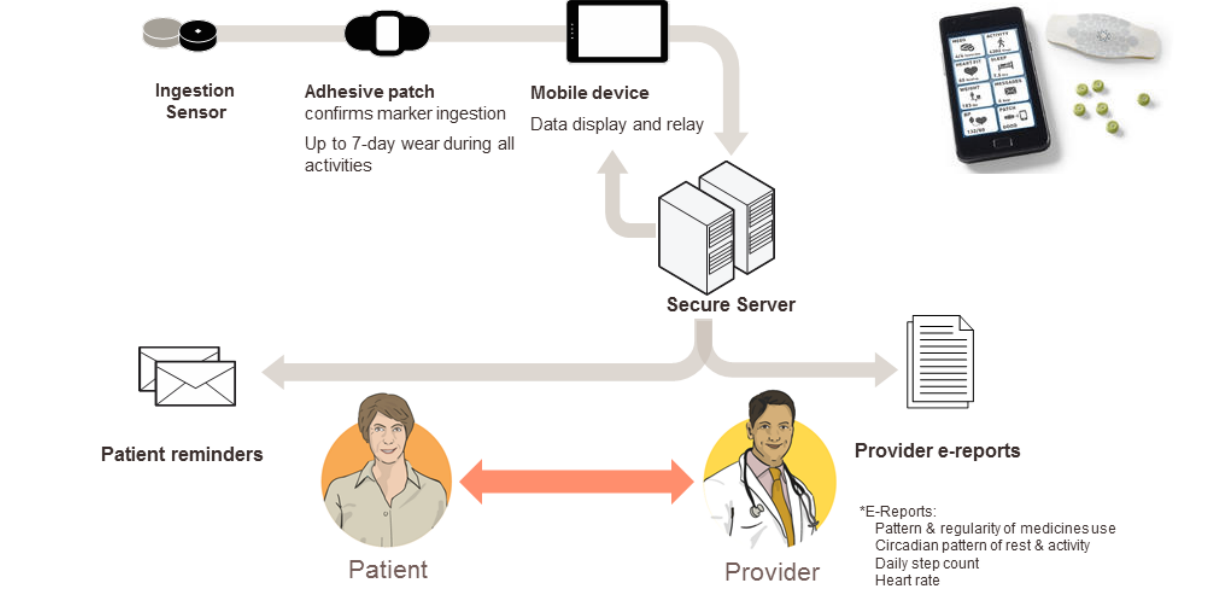
Figure 1. Overview of the Digital Health Feedback System to monitor medication adherence and self-management (figure courtesy of Proteus Digital